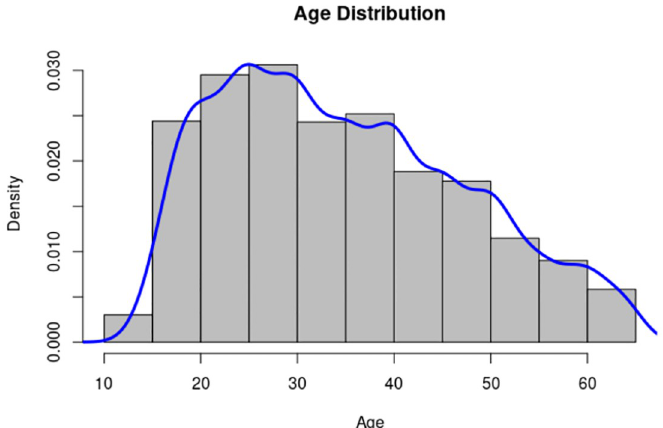
Fig 3. Age distribution in the